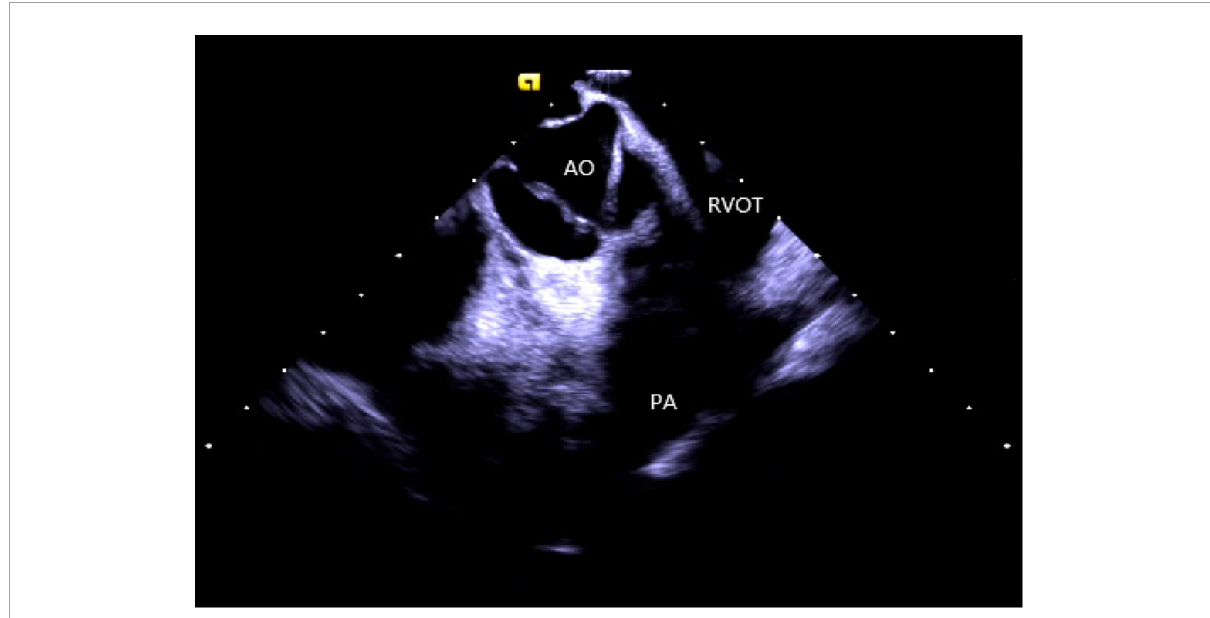
FIGURE3 The short axis of the aorta. AO, aortic valve; RVOT, right ventricular outflow tract; PA, pulmonary artery.